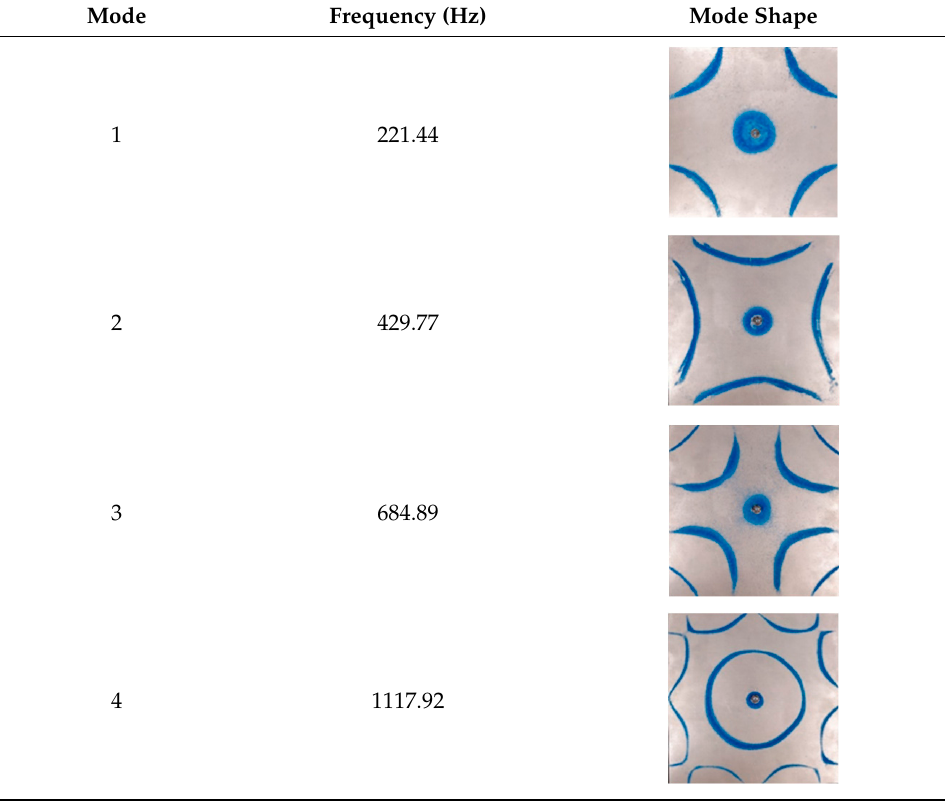
Table 3. Reference material parameters and design